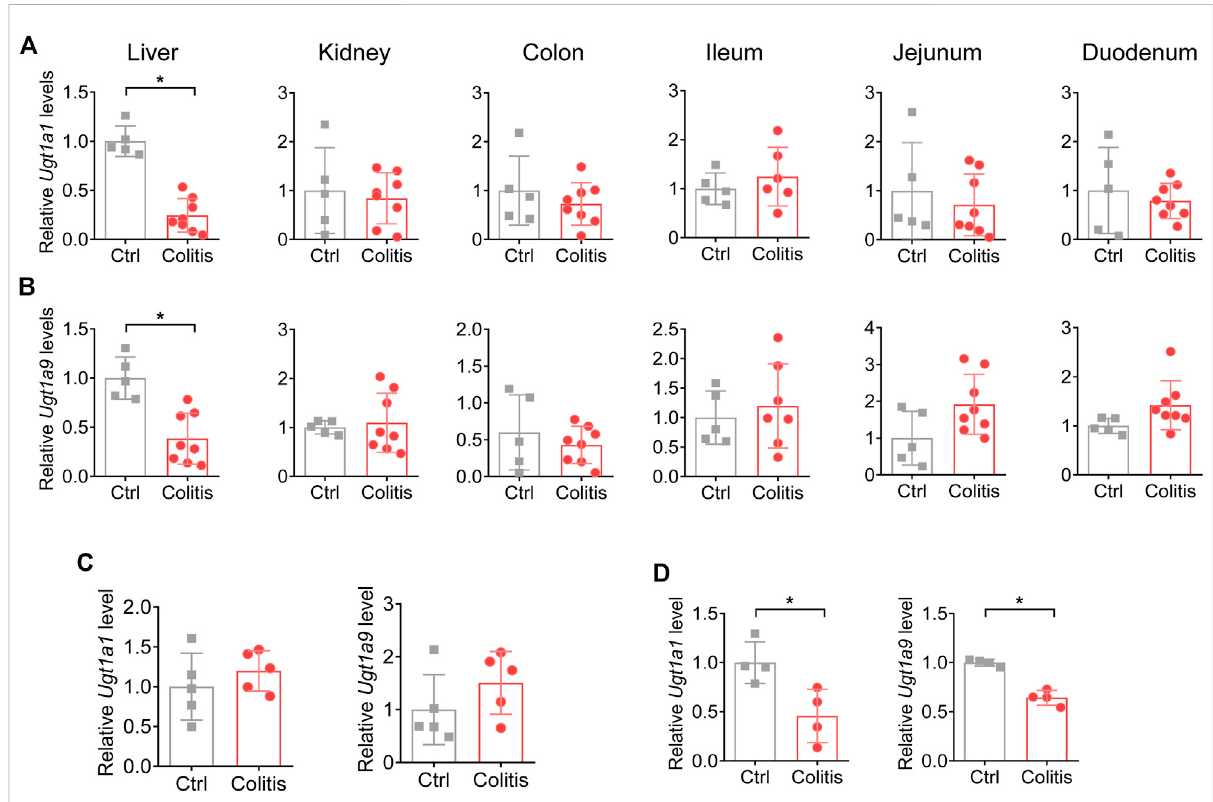
FIGURE 2 Colitis downregulates UGT1A1 and UGT1A9 in the liver but not in other metabolic tissues. (A) mRNA expression of UGT1A1 in the liver, kidney, colon, ileum, jejunum, and duodenum of colitis and control mice. (B) mRNA expression of UGT1A9 in the liver, kidney, colon, ileum, jejunum, and duodenum of colitis and control mice. (C) mRNA expression of UGT1A1 and UGT1A9 in the liver of mice with 1 day of DSS administration. (D) mRNA expression levels of UGT1A1 and UGT1A9 in the liver of Il-10 − / − and WT mice. * p < 0.05.